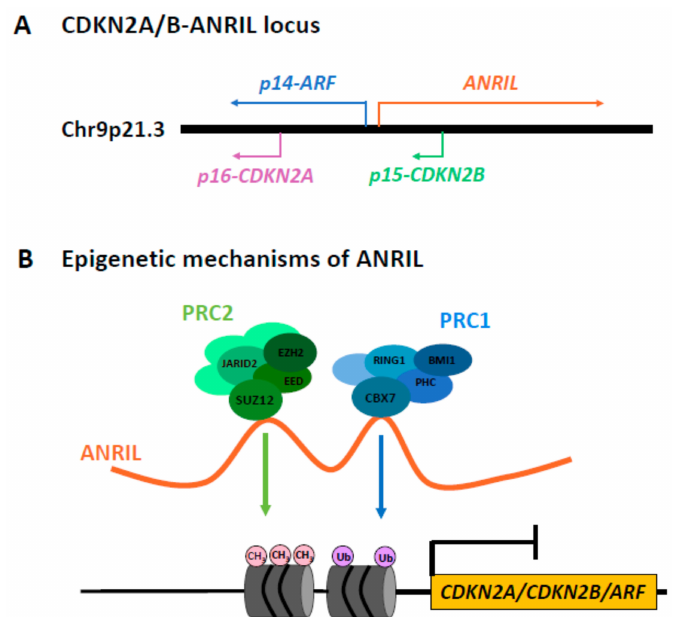
Figure 1. ( a ) Genomic organization of the human CDKN2A / B locus on chromosome 9p21.3, encoding for the three tumor suppressors p14-ARF, p15-CDKN2B, p16-CDKN2A, and for the long non-coding RNA (lncRNA) ANRIL. ANRIL partially overlaps CDKN2B , and is transcribed in the antisense orientation of the CDKN2B–CDKN2A–ARF gene cluster. ( b ) The direct interaction between ANRIL and the polycomb repressive complexes 1 and 2 (PRC1 and PRC2) allows maintenance of the transcriptional repression of the CDKN2A / B locus, via a cis -acting, polycomb-mediated epigenetic mechanism. PRC1 and PRC2 catalyse the mono-ubiquitination and the methylation of the histone code about the CDKN2A / B locus,